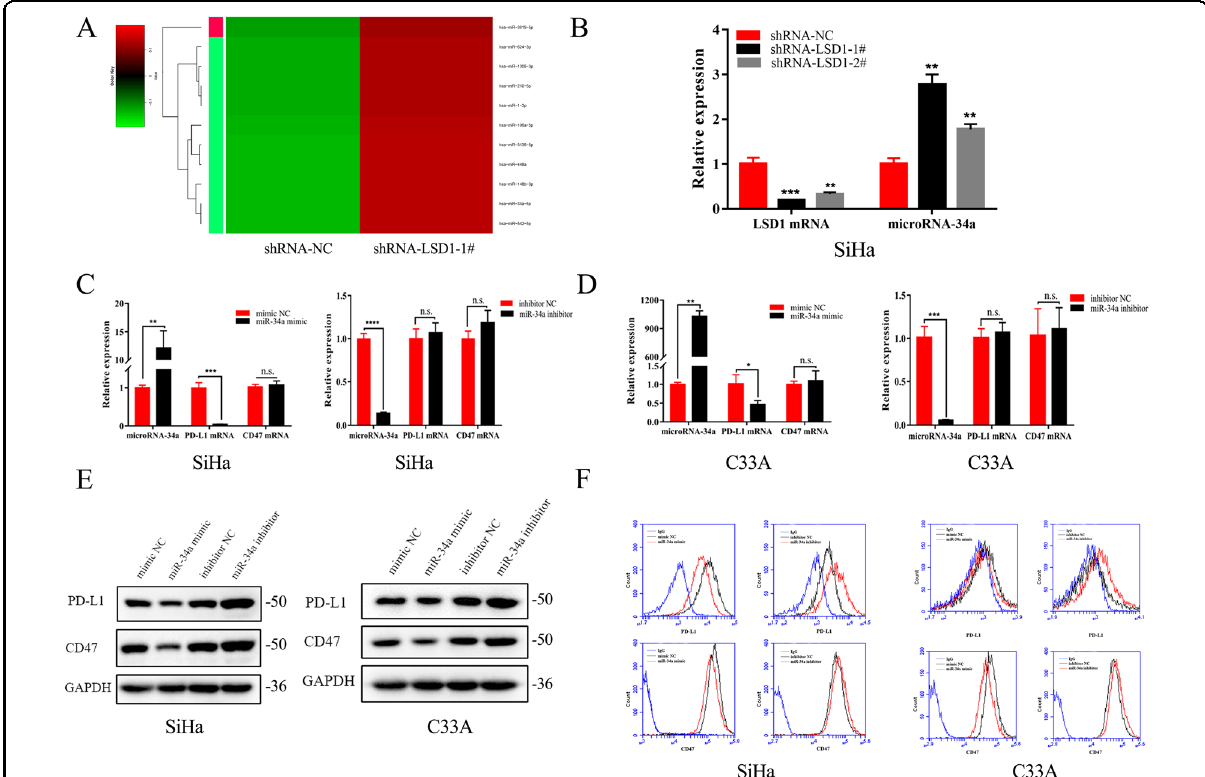
Fig. 3 LSD1 silencing reduces CD47/PD-L1 protein expression by upregulation of miR-34a. A MicroRNA sequencing indicated that miR-34a, which was predicted to target the 3 ′ UTR of CD47/PD-L1, was upregulated signi fi cantly after LSD1 knockdown in SiHa cells. B Changes in miR-34a expression after LSD1 knockdown in SiHa cells were con fi rmed by qRT-PCR ( n = 3 per group). C , D Changes in the expression of PD-L1/CD47 mRNA in SiHa and C33A cells after transfection with miR-34a mimics or inhibitors ( n = 3 per group). E Western blotting and F fl ow cytometry showed that miR-34a mimics upregulated the protein expression of CD47/PD-L1 in SiHa and C33A cells, whereas miR-34a inhibitors had the opposite effects. Each experiment was repeated three times. N.S. not signi fi cant. * p < 0.05; ** p < 0.01; *** p < 0.001; **** p <